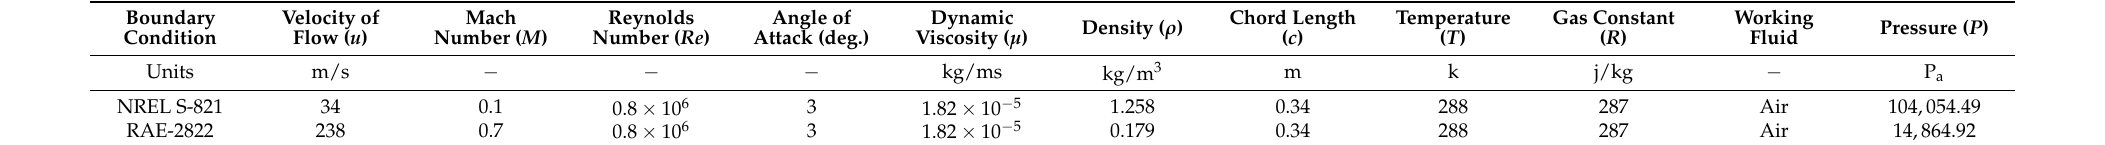
Table 1. Operating parameters for an Airfoil.